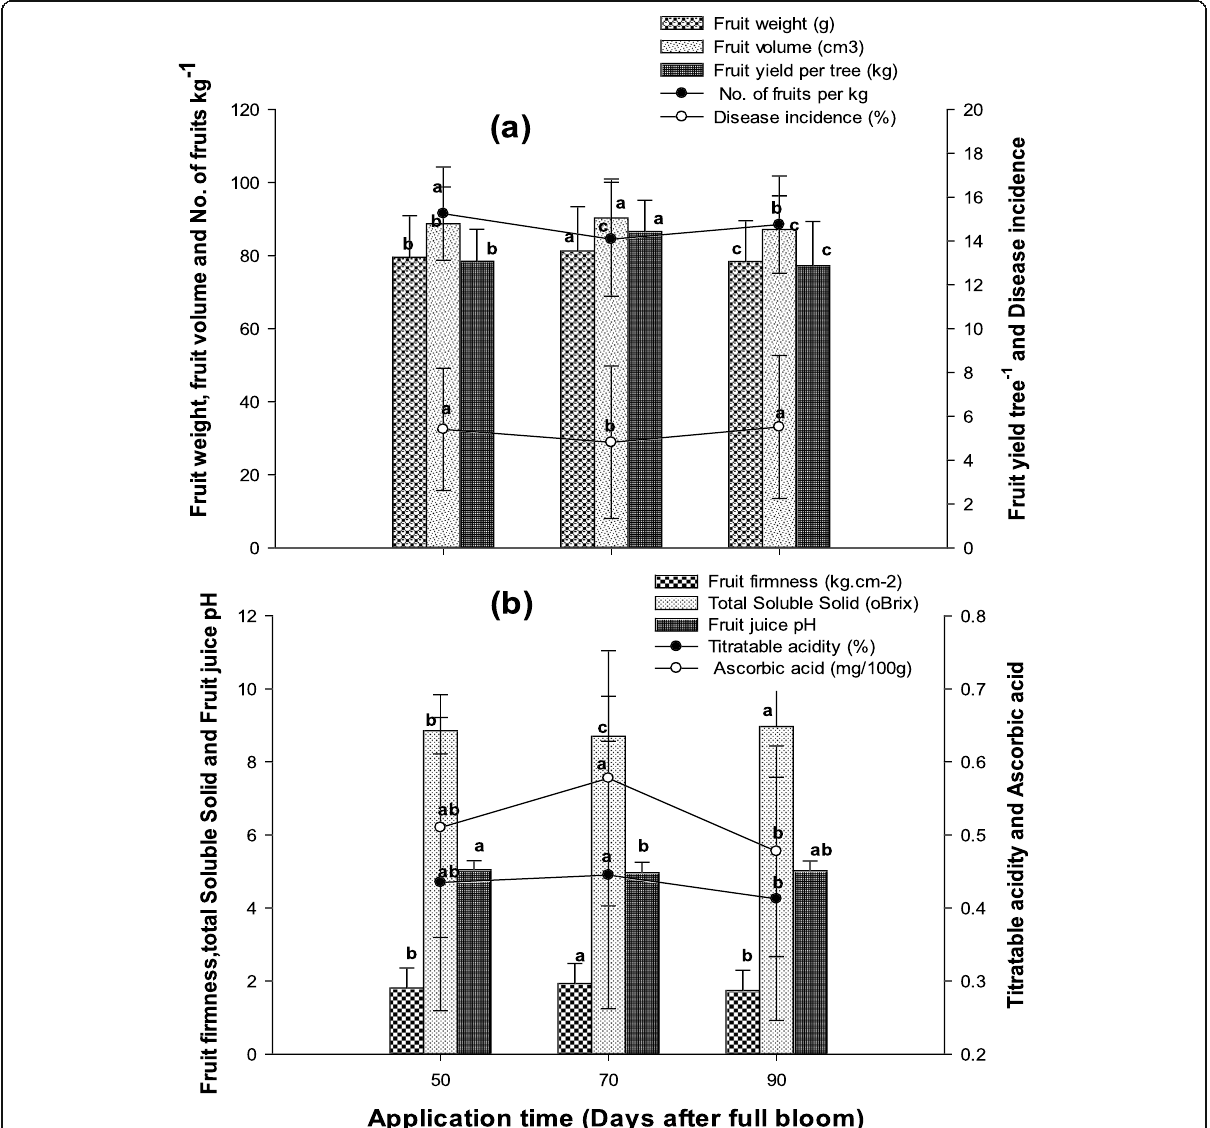
Fig. 4 Various attributes of peach as influenced by the application time of chitosan. The vertical bars represent standard error. Different letters next to the mean values in each bar indicate a significant difference (LSD p ≤